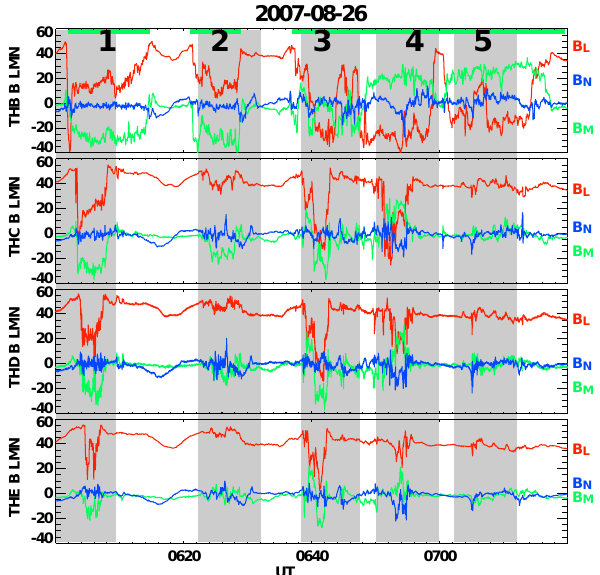
Fig. 4. Magnetic fields [in nT] of THB, THC, THD and THE in the LMN coordinate system at the time interval from 06:00 to 07:20UT. The discussed events are numbered and the green bars mark inter- vals when THB was located in the magnetosheath.